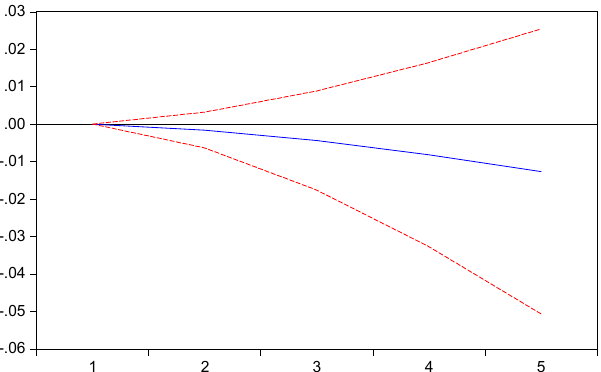
Figure 3. Impact of individuals searching on internet for health-related information on payments made by households for healthcare, expressed as euro per inhabitants.